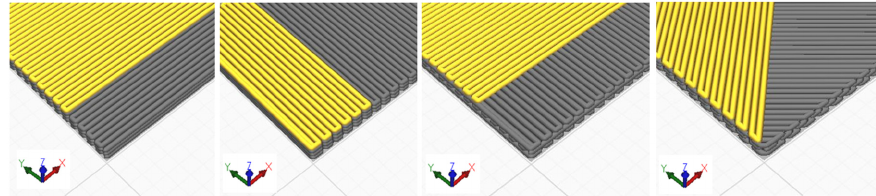
◦ , 90 ◦ , 0 ◦ / 90 ◦ , − 45 ◦ / 45 ◦ , respectively from left to Figure 3. Raster Orientations 0°, 90°, 0°/90°, − 45°/45°, respectively from left to right. Figure 3. Raster Orientations 0